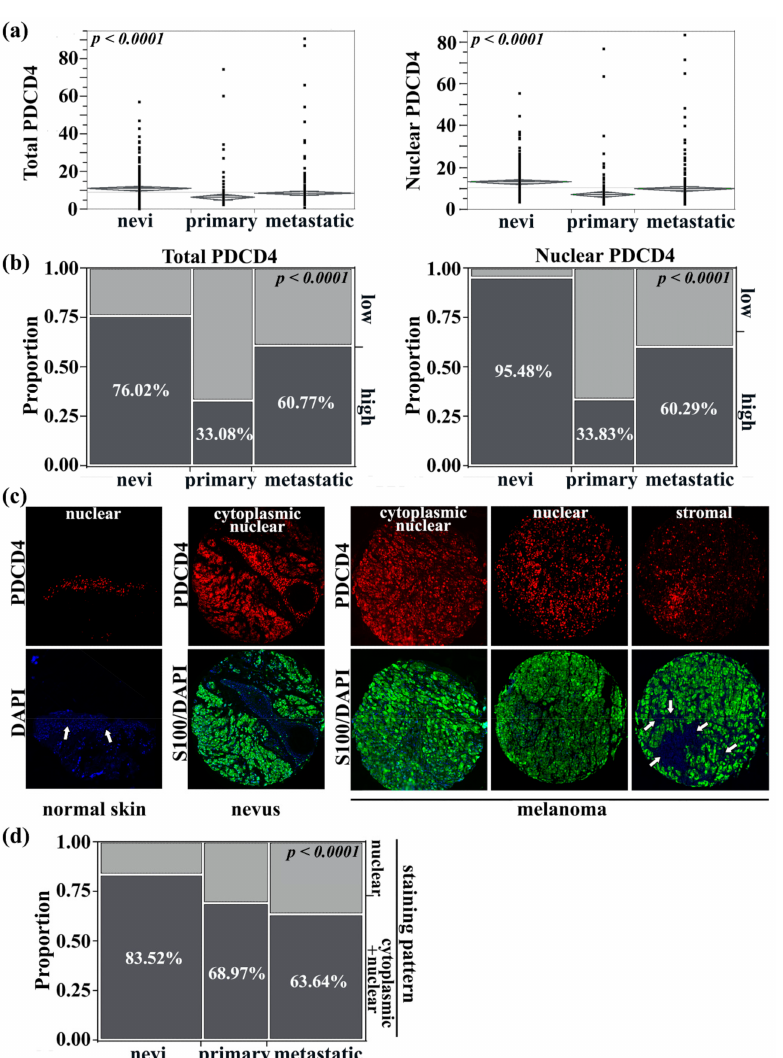
Figure 1. Expression patterns of PDCD4 during melanoma progression. ( a ) PDCD4 expression was higher in both the S100-positive melanocyte/melanoma (‘total PDCD4 (cid:48) ) and DAPI-positive nuclear (‘nuclear PDCD4 (cid:48) ) compartments of benign tissue compared to malignant tissue (ANOVA, p < 0.0001). ( b ) High PDCD4 expression was predominantly in nevi, decreased in primary melanomas, but increased again in metastatic melanomas—this pattern was evident when analyzing total PDCD4 or nuclear PDCD4. ( c ) Representative photos of PDCD4 (red) compartmentalization in the cytoplasmic (green, defined by S100) vs. nuclear (blue) in normal skin vs nevi vs melanoma. For melanoma, three different staining patterns are being shown for PDCD4: cytoplasmic and nuclear, predominantly nuclear, or stromal. White arrows indicate the skin epidermis (left-most panel) or tumor stroma (right-most panel). Magnification 10 × . Higher 40 × magnification photos of the top row are shown in Figure S1. ( d ) During progression from nevi to primary and then to metastatic melanoma, cytoplasmic/nuclear PDCD4 expression decreases (dark gray) compared to nuclear-only expression (light